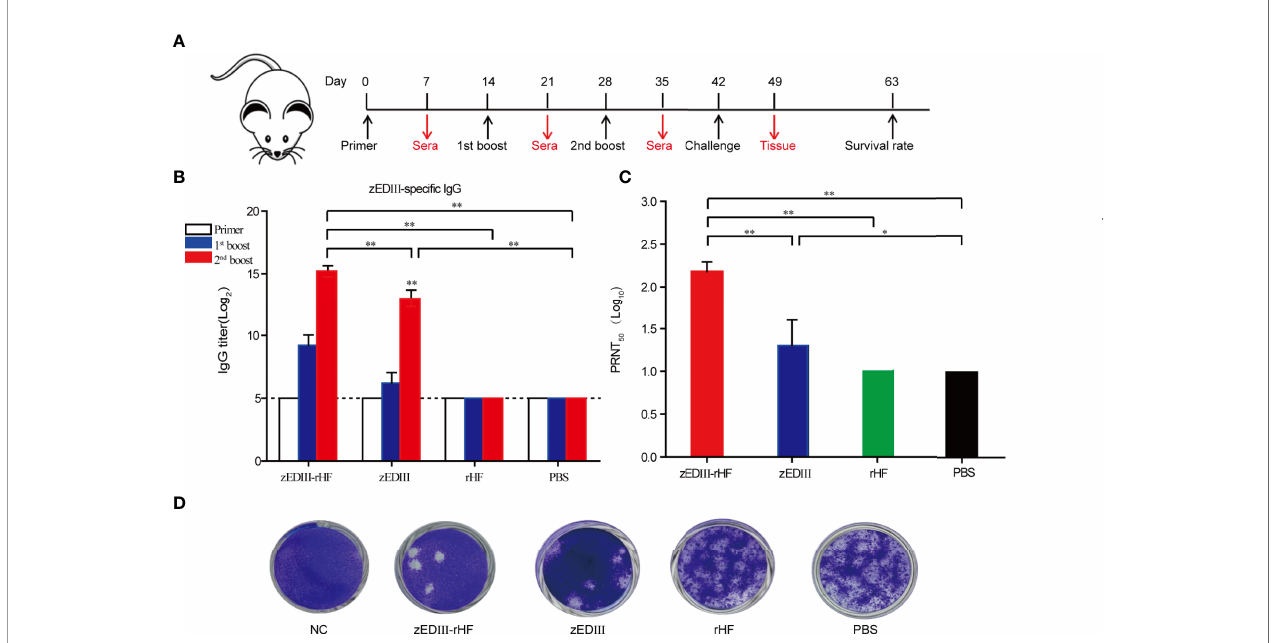
FIGURE 2 | Humoral immunity induced by zEDIII-rHF in mice. (A) Scheme for immunization, virus challenge and sampling. (B) ELISA detection of zEDIII-speci fi c IgG in sera after each immunization, n = 5. (C) Serum neutralizing antibody titers. Samples were diluted in a twofold gradient. (D) Number of viral plaques in Vero cell cultures (Vero cells were prepared in advance in a 24-well plate, and the ZIKV dose was 100 PFU). The data in 2b and 2c are shown as the mean and standard deviation (mean ± SD) analyzed by Student ’ s t-test; *P < 0.05, **P < 0.01 . In (B) , the dotted line represents the limit of detection (LOD), which is the lowest dilution of the positive sample.